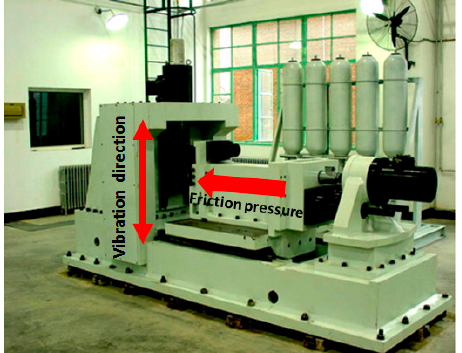
Figure 2. Linear friction welding (LFW)-20T linear friction welding equipment.